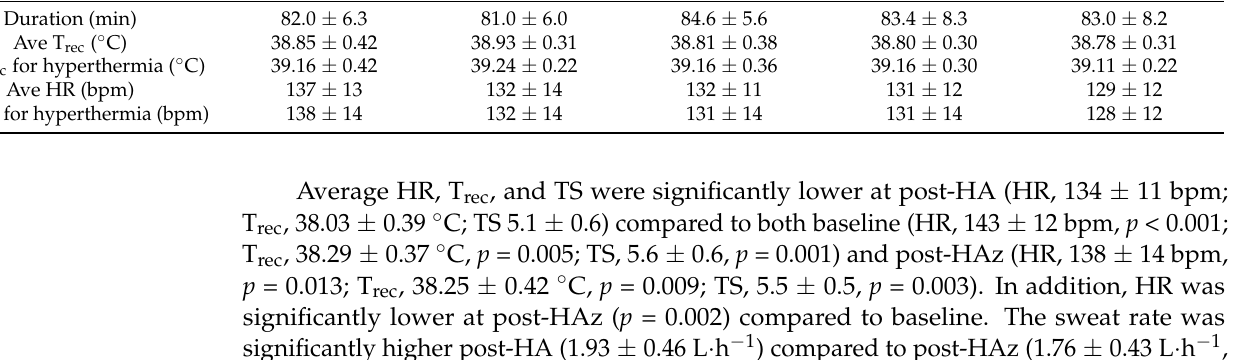
Table 1. Duration, average rectal temperature (T rec ), average T rec for hyperthermia period, average heart rate (HR), and average HR for hyperthermia period during heat acclimation from Day 1 to 5.